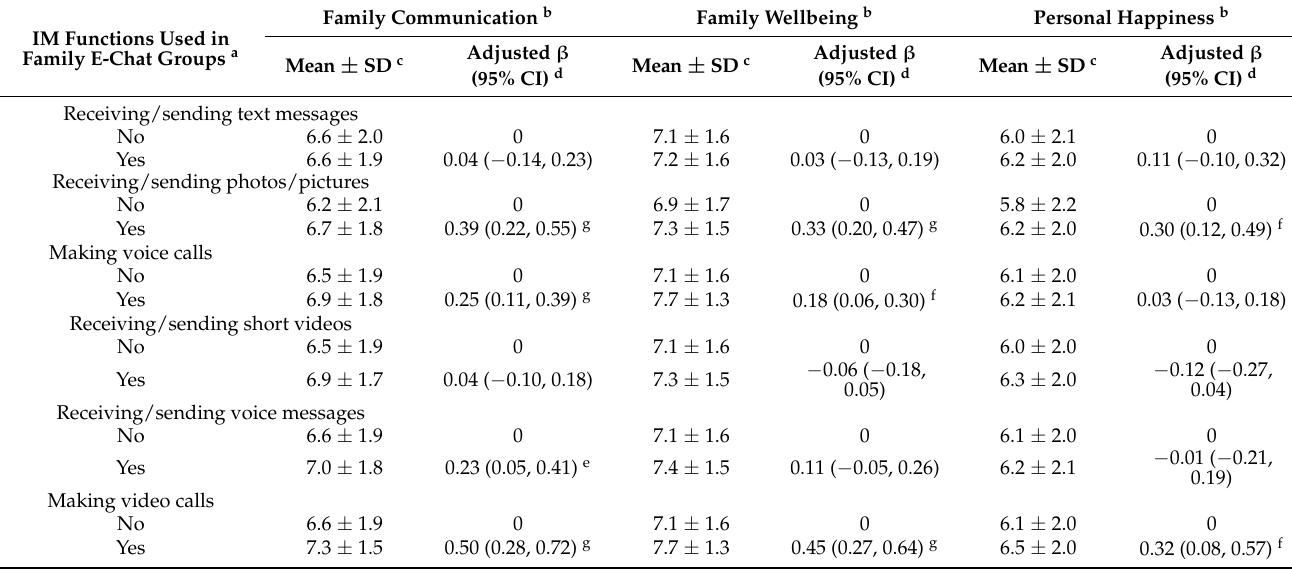
Table 4. Associations of IM functions used in family e-chat groups with family communication, family wellbeing, and personal happiness ( n = 4046) a .